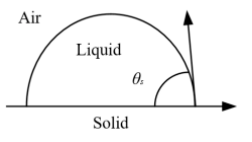
Figure 9. The static contact angle.